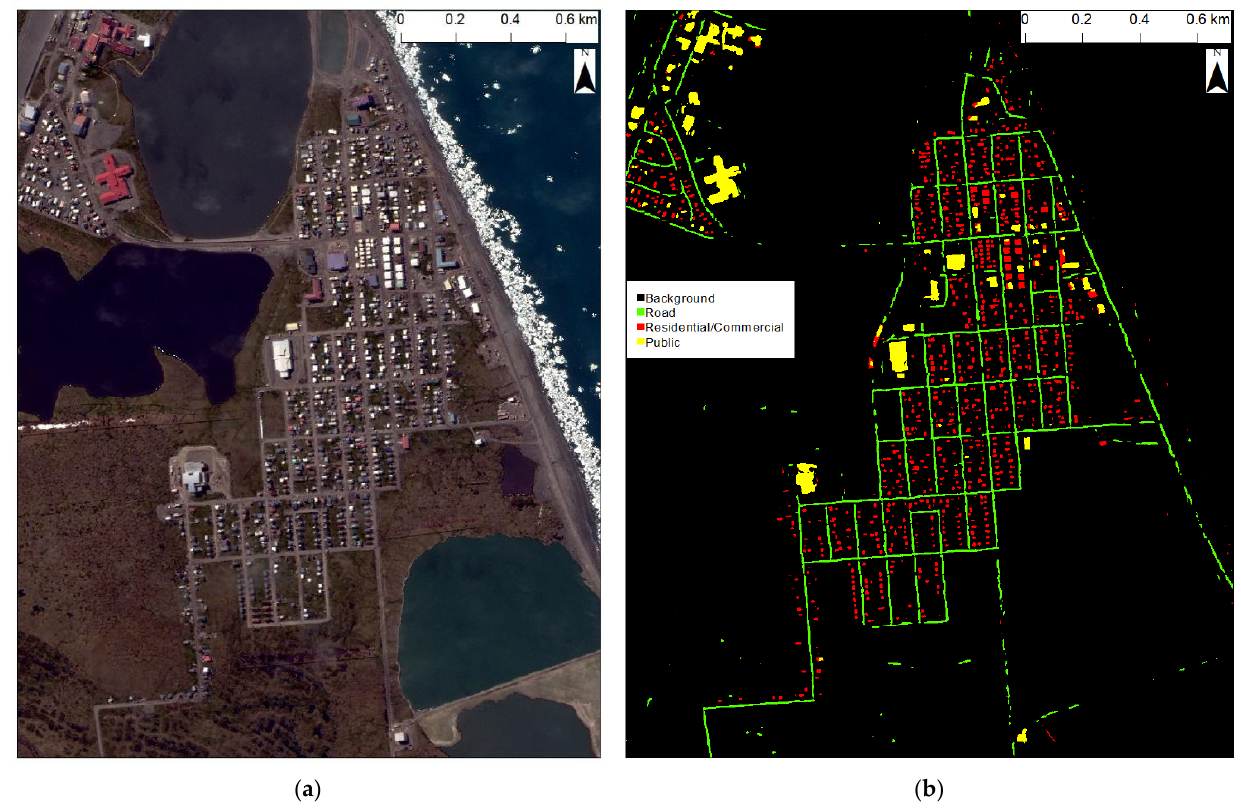
Figure 8. ( a ) Original satellite image and ( b ) final infrastructure map of the Utqiagvik site resulting from the automated detection workflow. Predicted tiles output by the model were stitched together as part of the output post-processing stage. Imagery © DigitalGlobe, Inc.